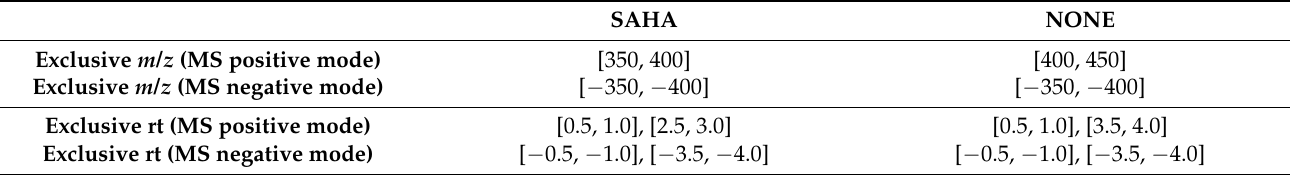
Table 1. Statistical mode value intervals calculated for each histogram of positive and negative ionization detection modes in Mass Spectroscopy (MS), based on the population of m / z and retention time (rt)